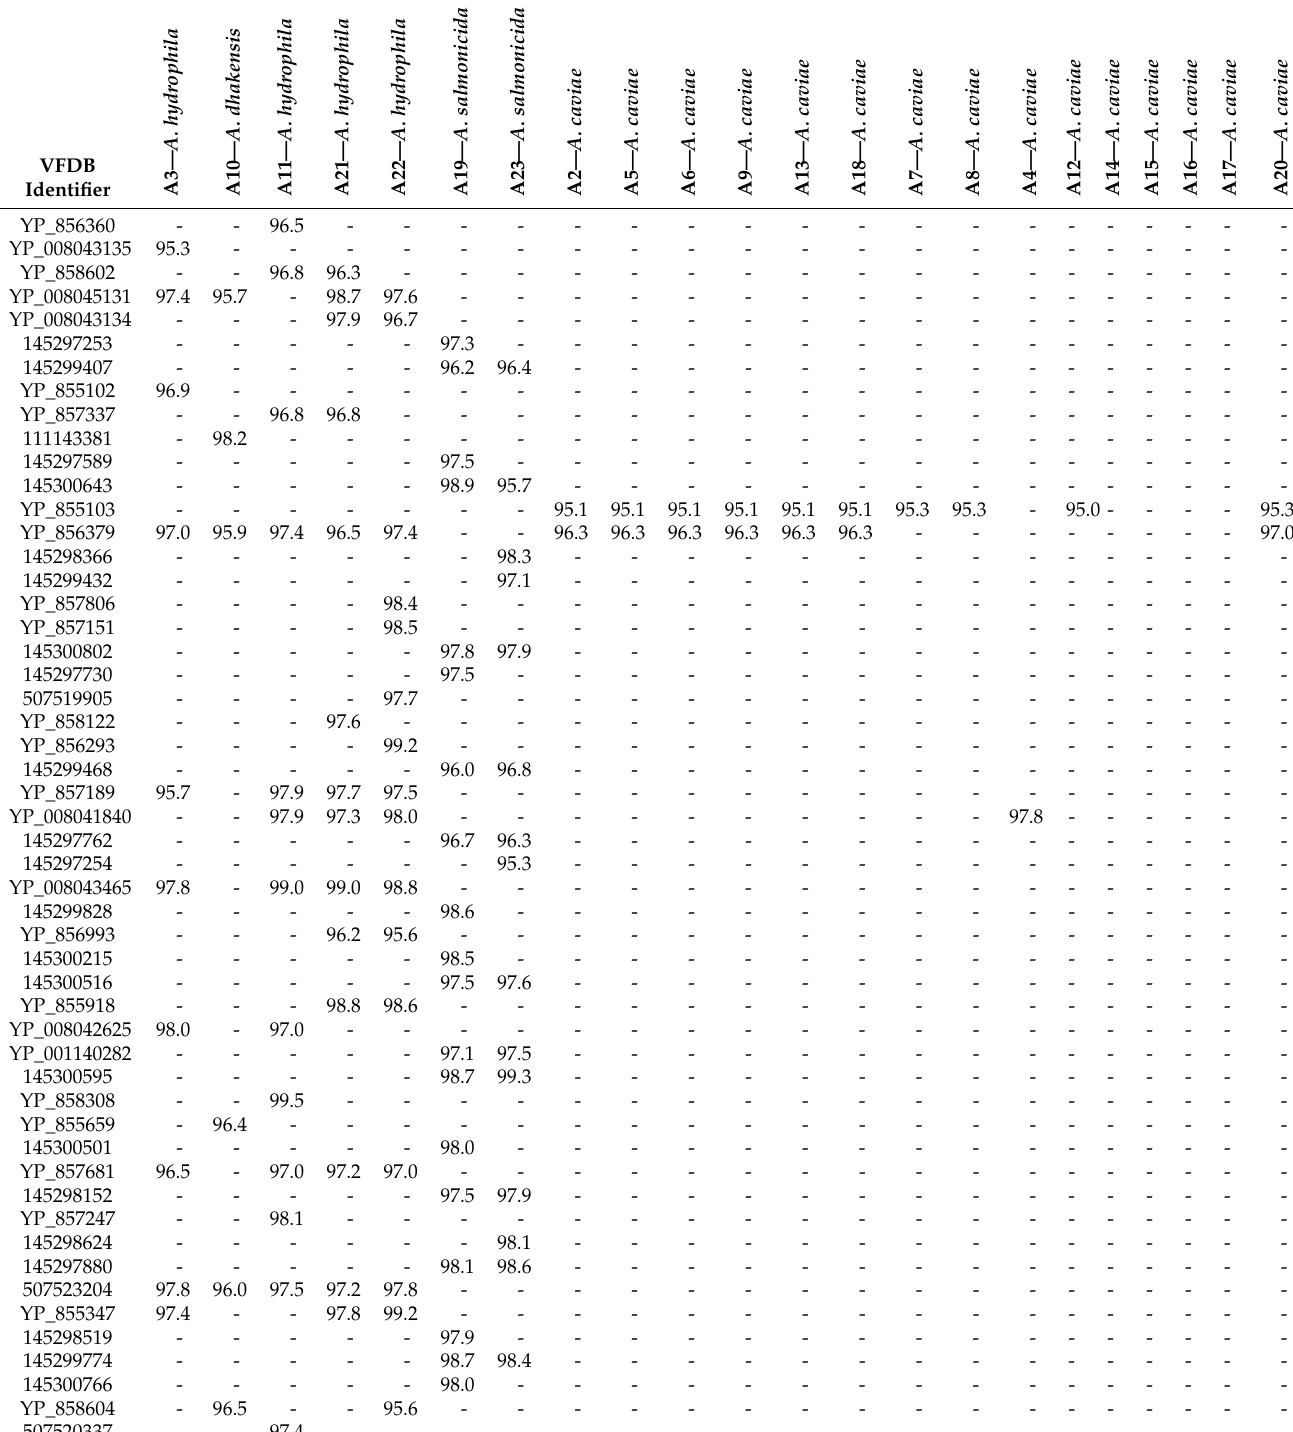
Table 4. Percent alignment of genes identified in Aeromonas hydrophila , Aeromonas salmonicida , and